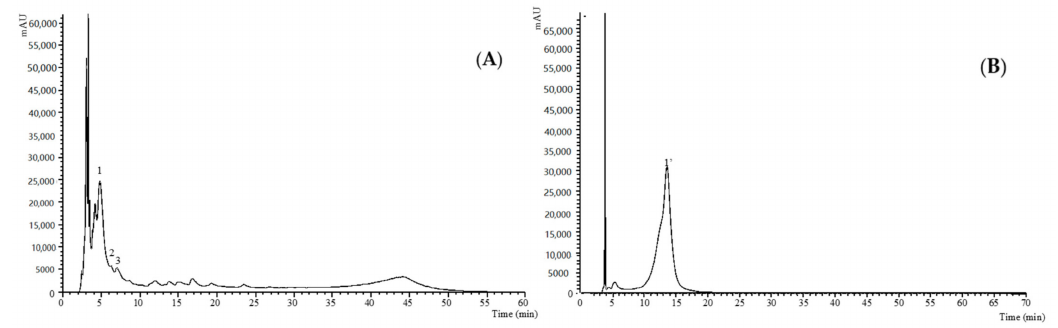
Figure 1. Profile of non-anthocyanin ( A ) and anthocyanin ( B ) phenolic compounds from the hydroethanolic extracts of the S. melongena L. (whole fruit and epicarp, respectively) recorded at 280 nm (i) and 520 nm (ii). The peak number correspondence is shown in Table